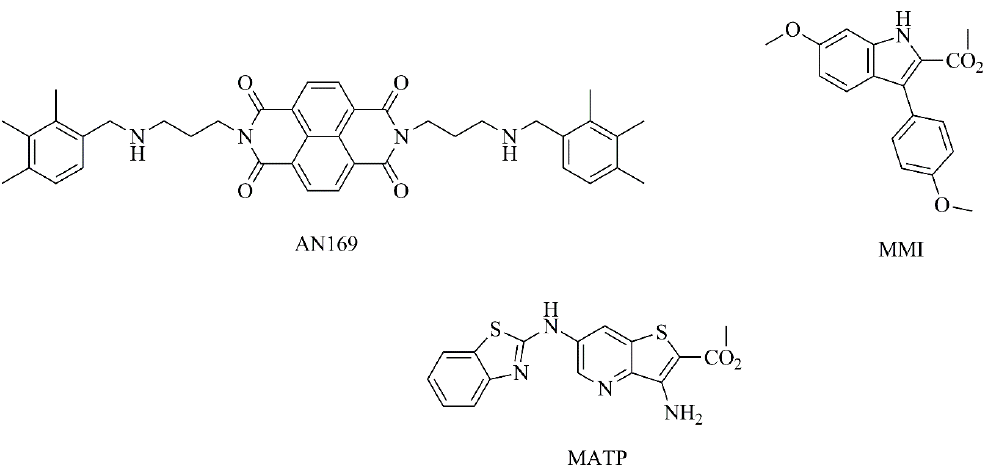
Figure 8. Chemical structures of AN169, MMI and MATP.